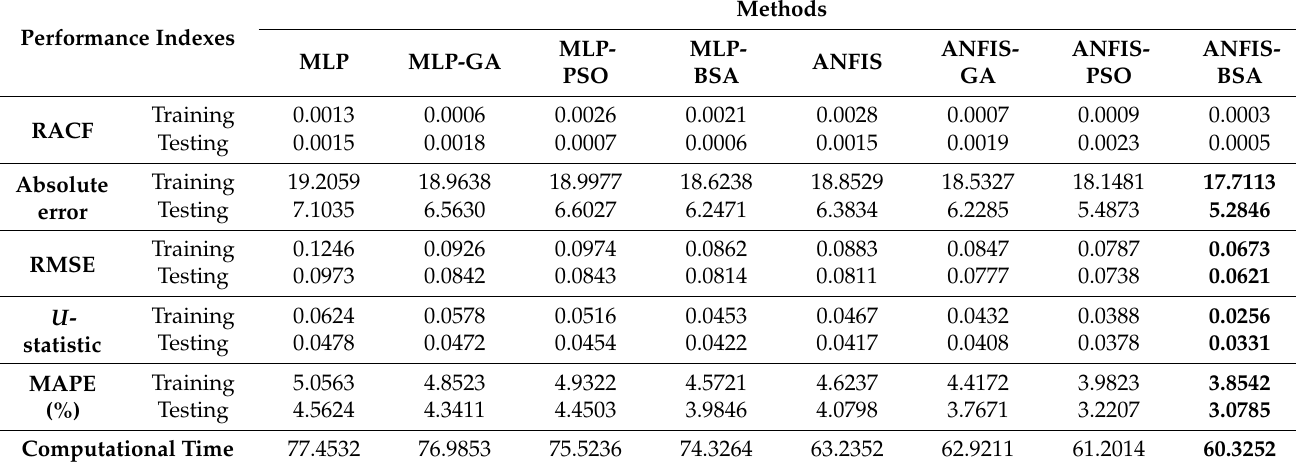
Table 5. Comparison performance indexes of multiple metaheuristic techniques corresponding to the forecasting accuracy for EPF in February 2018 in